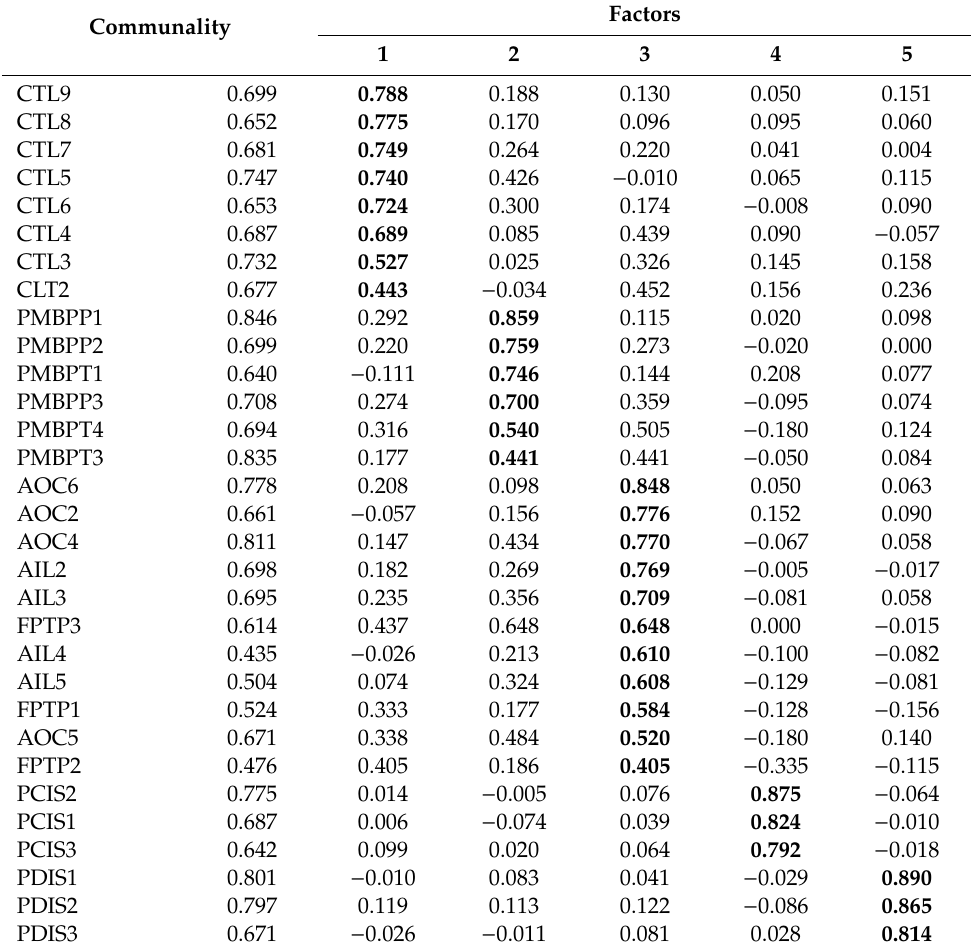
Table 2. Rotated factor